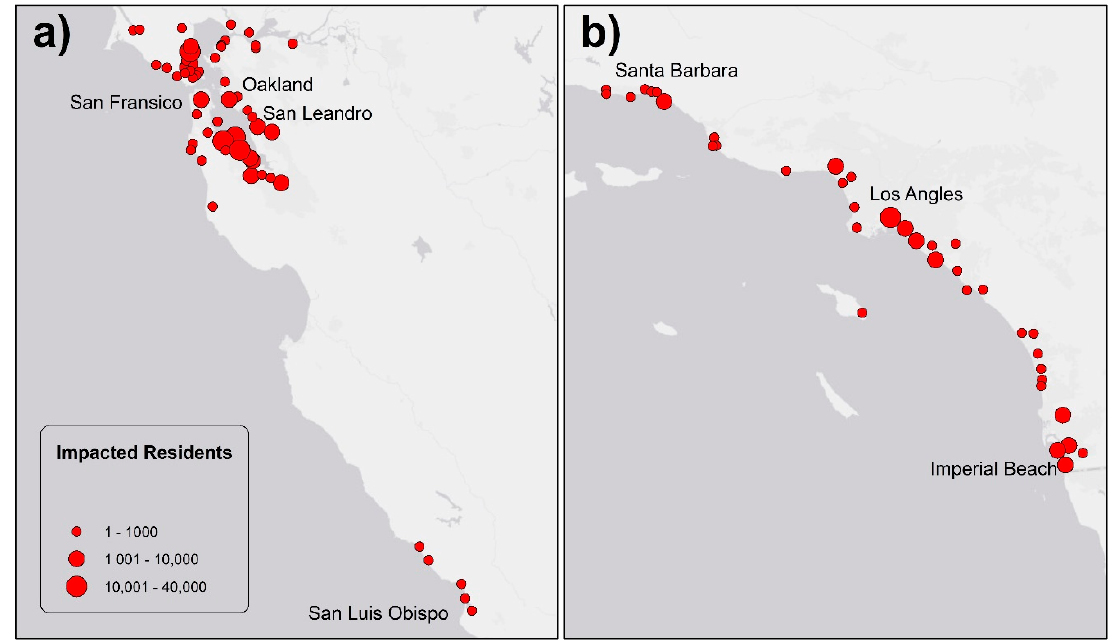
Figure 1. Number of residents in hazard zones caused by 1 m of SLR (expected to occur in this century) in ( a ) northern California and ( b ) southern California. We have achieved data from USGS Hazard Exposure Reporting and Analytics (HERA) that is publicly available [2], and mapped using ArcGIS.